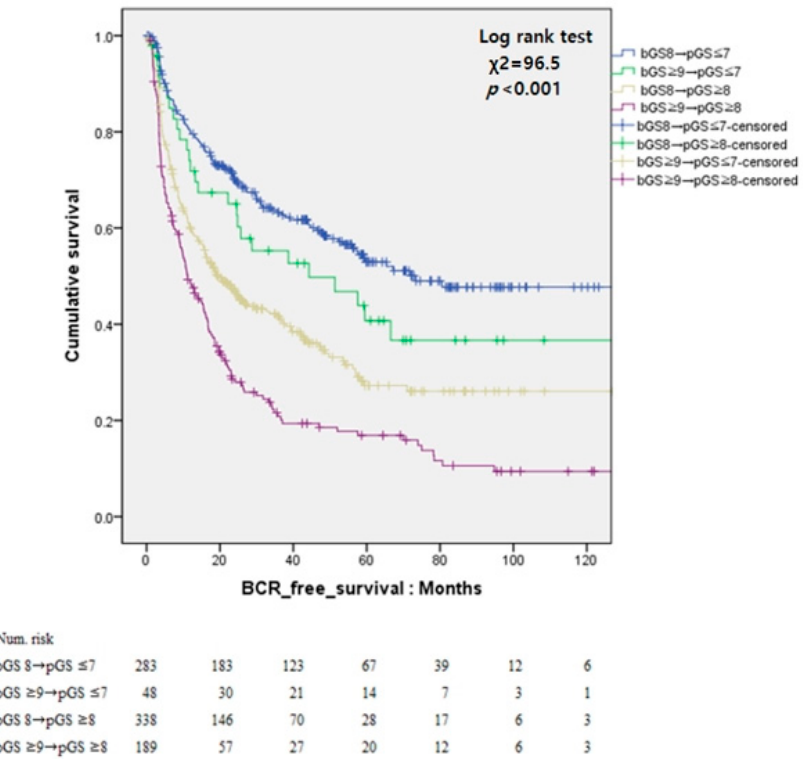
Figure 3. Kaplan–Meier curves for biochemical recurrence (BCR)-free survival according to bGS and pGS.